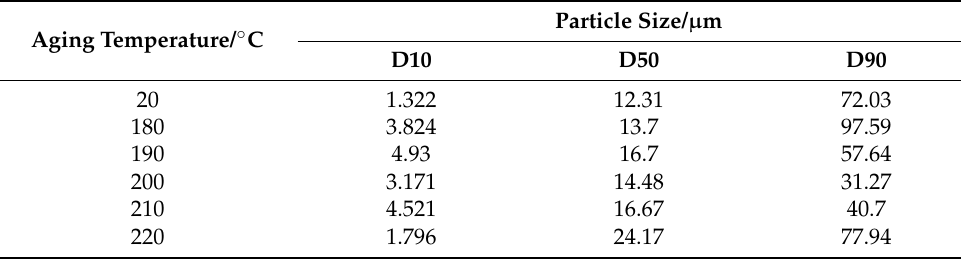
Figure 13. Particle size distribution curve of drilling fluids after aging. Table 7. Particle size value of muds after aging.